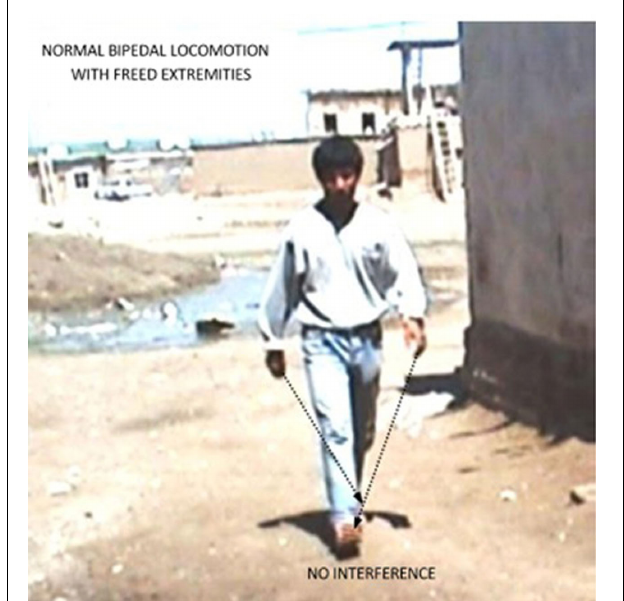
FIGURE 8 | Diagonal-sequence BL in the case IV-24: left arm-right leg and right arm-left leg as indicated by the arrows. Notice no interference between arms and legs with freed hands and